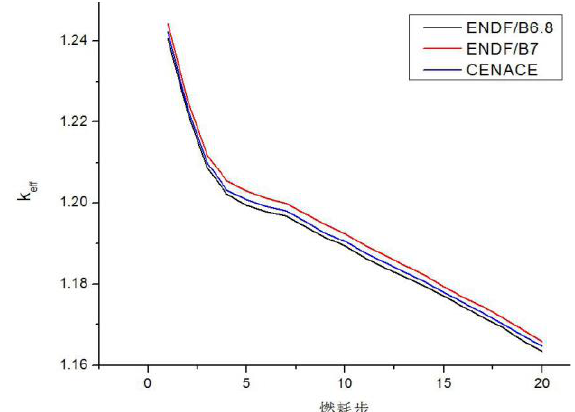
Fig. 5. Results of AFA3G31000 assemble in first 20 steps